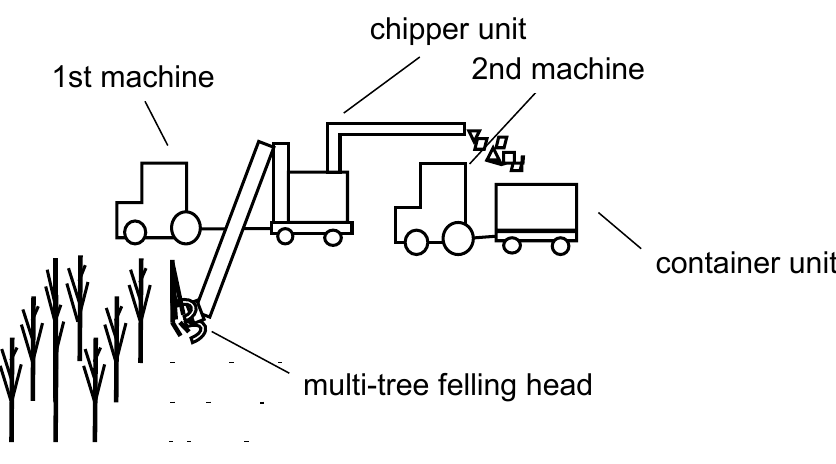
Figure 2. Assumed harvesting system.